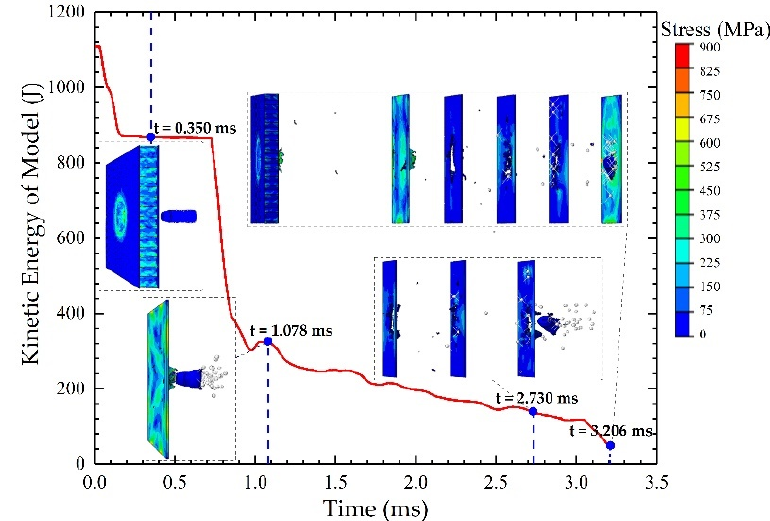
Figure 5. Simulation results of the projectile damage.